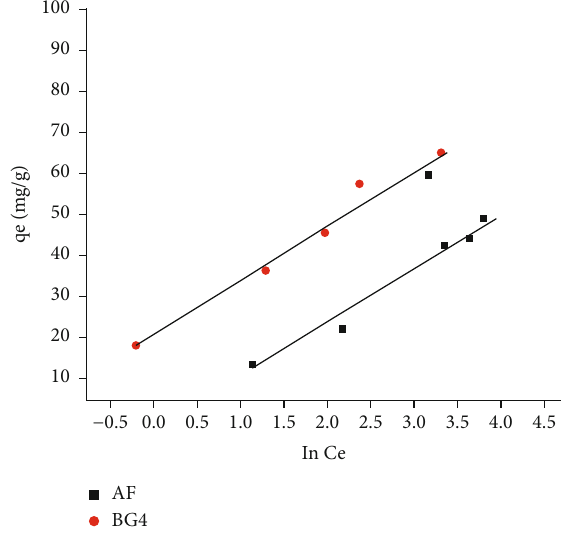
Figure 12: Temkin plot for adsorption of basic green 4 dye onto